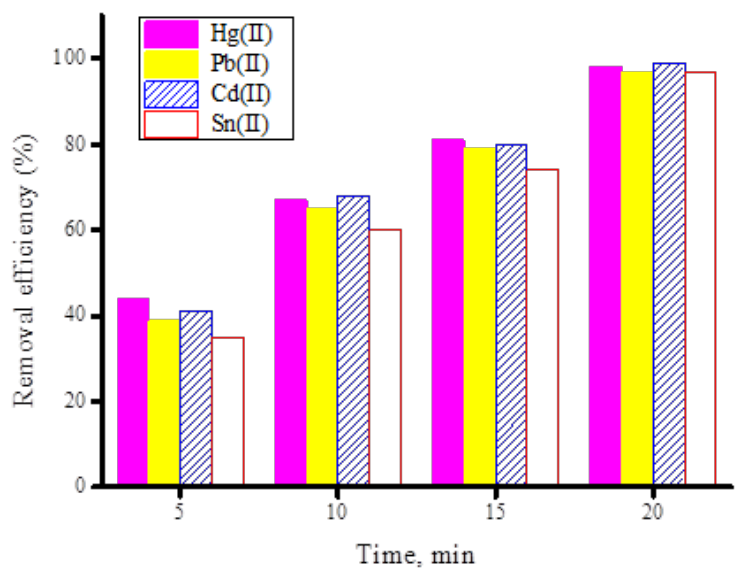
Figure 13. Removal efficiency (%) of heavy metal ions (20 mg/100 mL) using 50 mg of free fullerene